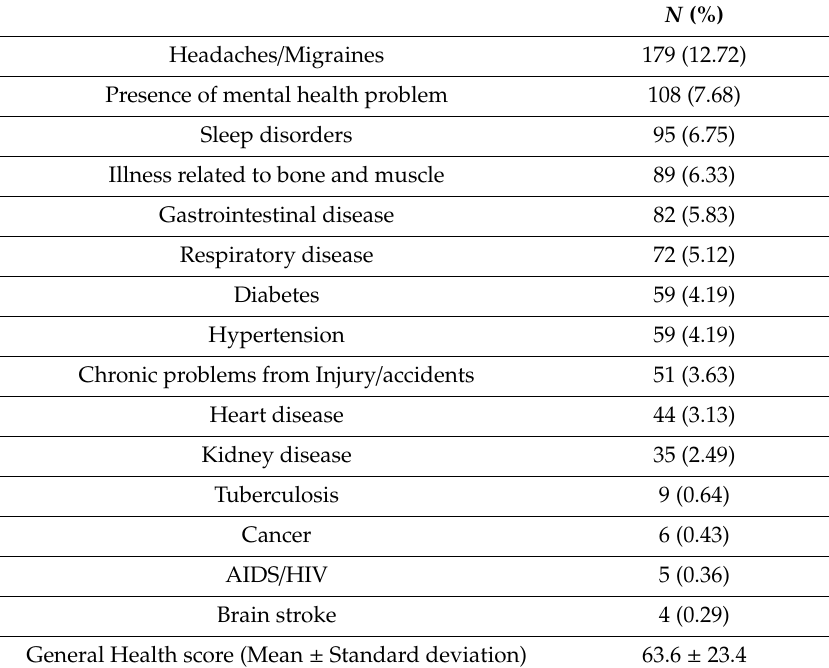
Table 3. Health status of migrants and refugees.